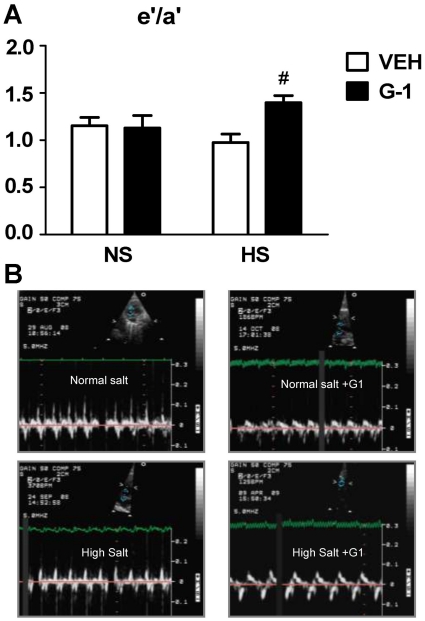
GPER activation with G1 improves myocardial relaxation in normal- and salt-fed mRen2.Lewis females.
a. Data represent mean ± SEM. e'/a′  =  early mitral annular velocity-to-late mitral annular velocity ratio. # P<0.05 compared to NS +G-1 (Salt x G-1 interaction: P = 0.036). b. Representative tissue Doppler images of early (e') and late (a') septal mitral annular velocities from each treatment group.